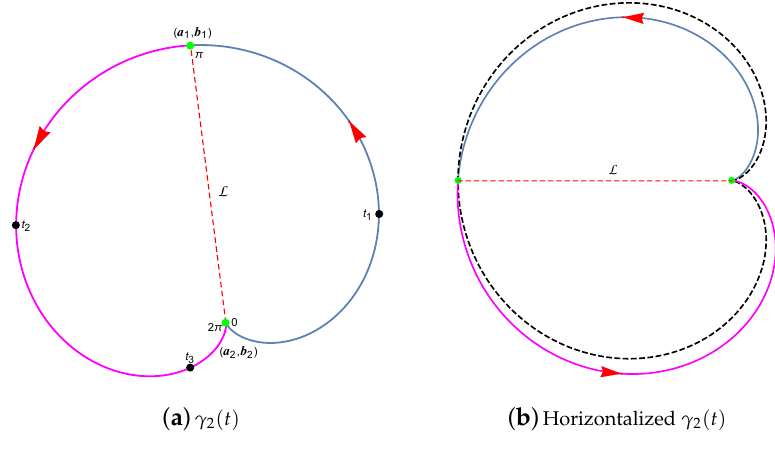
Figure 4. γ 2 ( t ) and the horizontalized γ 2 ( t )